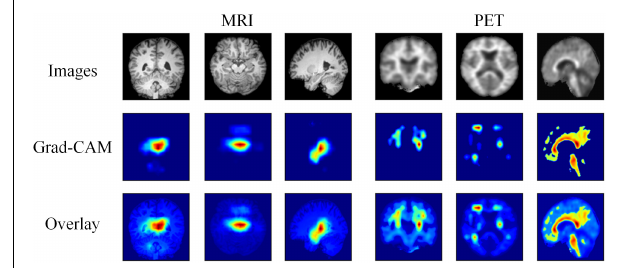
FIGURE 4 | Visualization results of the MRI and PET images, the corresponding Grad-CAMs obtained by our method, and the associated overlays.